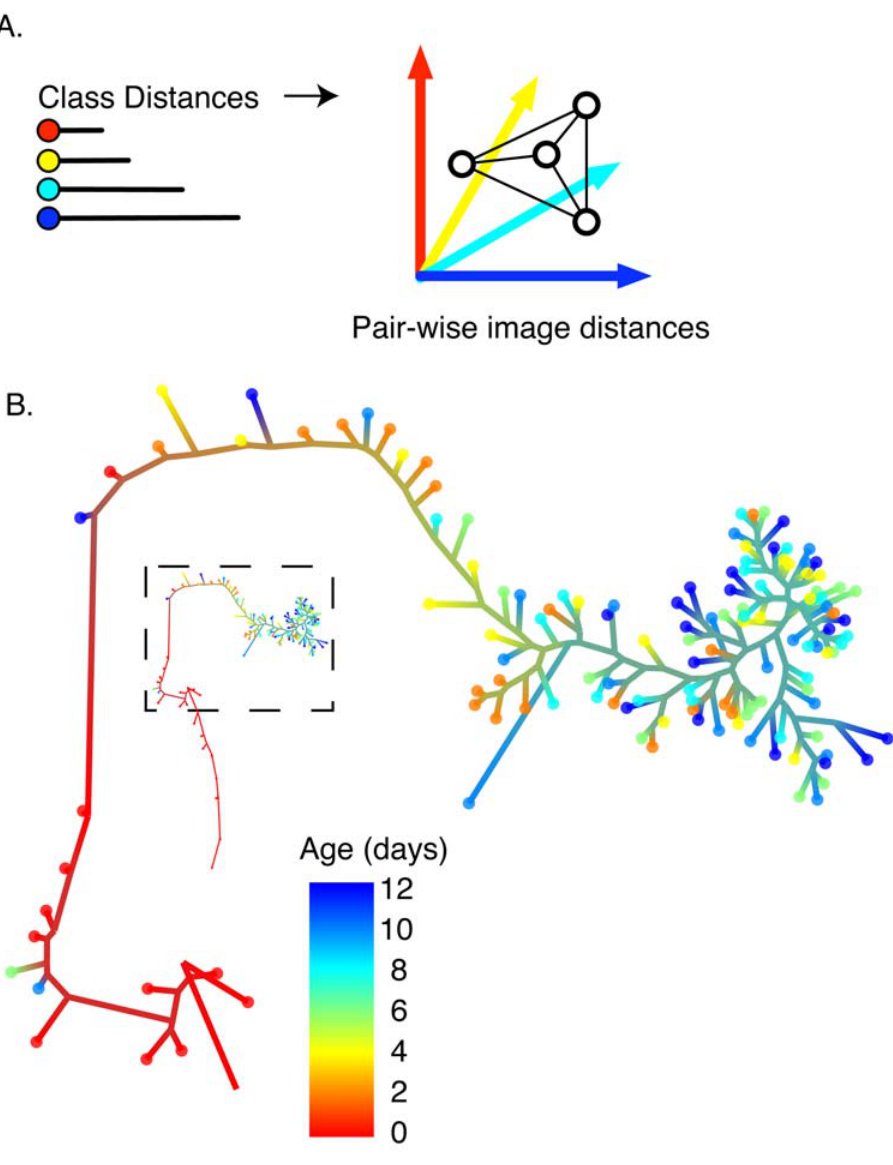
Figure 2. The aging model built on pharynx images from adult days 0–12 properly ordered the images by age. (A) Pair-wise image distances used to generate the dendrogram were calculated in the class-distance subspace, where each dimension is the distance from a test image to the centroid of an age-class. (B) Relationships between adult pharynx images from early to late life as determined by the aging model. Circles at branch end-points represent individual pharynx images, with color indicating the animal’s age at the time of imaging. Branch lengths represent pair- wise distances between images, and branch colors represent the ages of proximal images. This diagram shows that images could be classified into categories corresponding to early adulthood (day 0, red), middle adulthood (days 2 and 4, orange) and late adulthood (day 6 and older, green and cyan). For training, 85 images from fem-1(hc17) adults aged day 0 to 12 were used for each class. The dendrogram was constructed from 20 test images selected at random from each